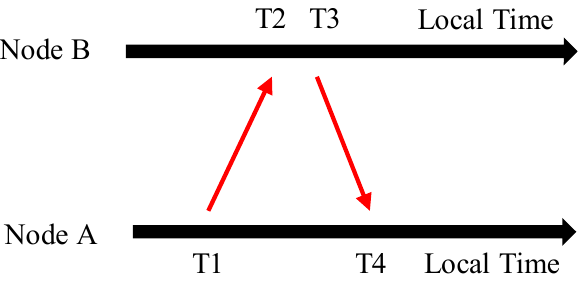
Figure 3. Two-way handshake between a pair of nodes.